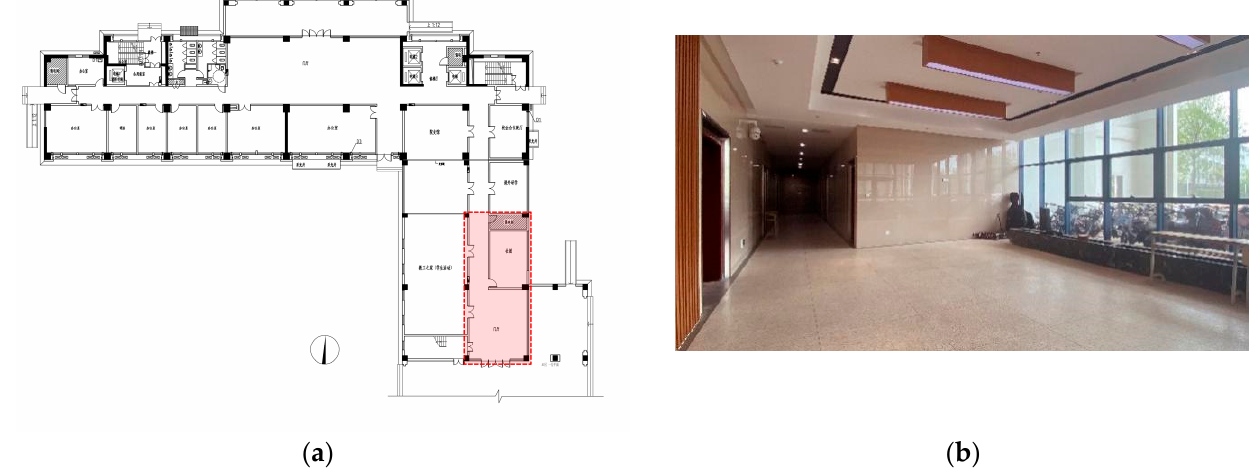
Figure 3. The first-floor cafe before optimization of t. ( a ) Original plan. ( b) Photo. (2) The third-floor terrace (Public/Alone):